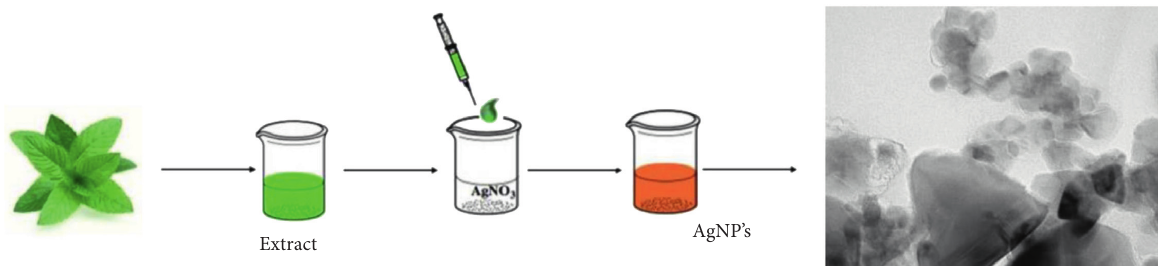
Figure 6: Schematic figure of green synthesis of AgNPs